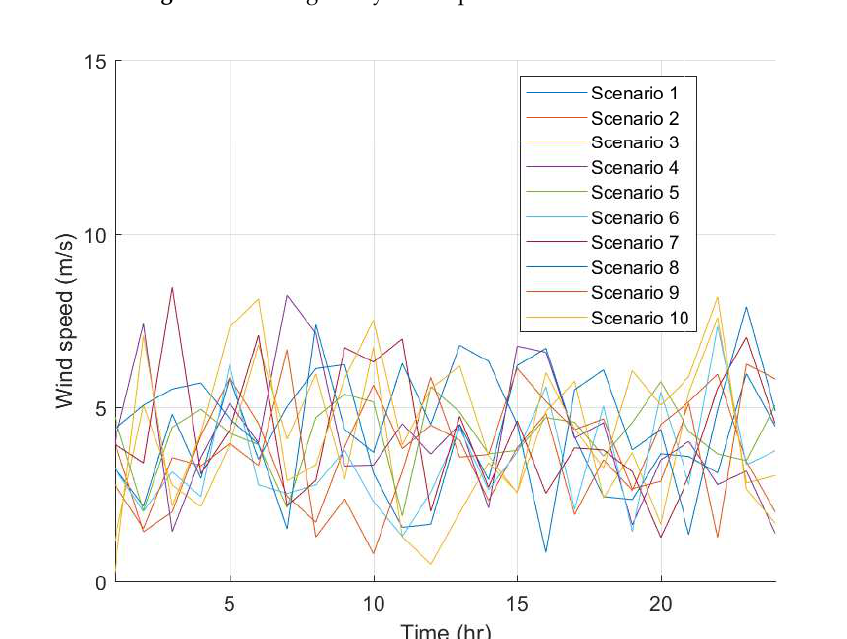
Figure 11. Hourly wind speeds during the first twenty-four hours of the ten